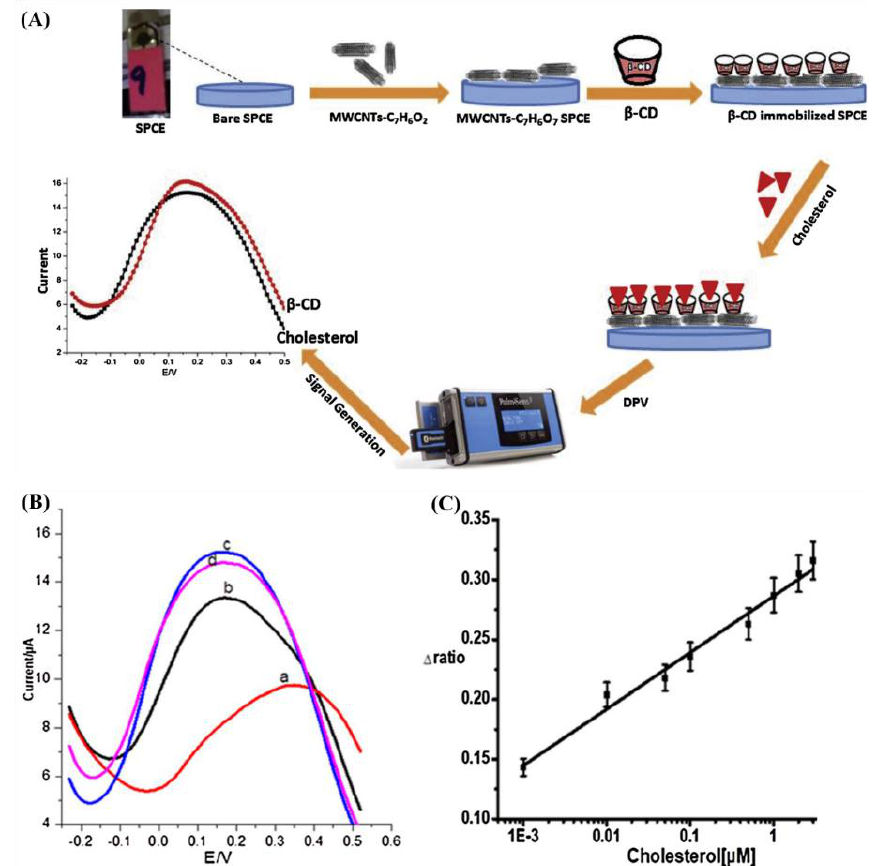
Figure 8. ( A ) schematic illustration of the designed electrochemical sensor for the detection of cho- lesterol, DPV response curves ( B ) of 2.0 mM [Fe(CN) 6 ] 4–/3– redox probe at a scan rate of 100 mV s −1 for bare SPCE (a), MWCNTs/SPCE (b), MWCNTs/β–CD (80 mg mL −1 ) immobilized–SPCE (c), and MWCNTs–β–CD/SPCE incubated with cholesterol (0.01 μM) (d). ( C ) The calibration curve corresponding to the detection of cholesterol based on the ∆ ratio , where ∆ ratio was calculated as a function of current before and after incubation of cholesterol [22]. Reprinted with permission from ref. [22]. Copyright 2018